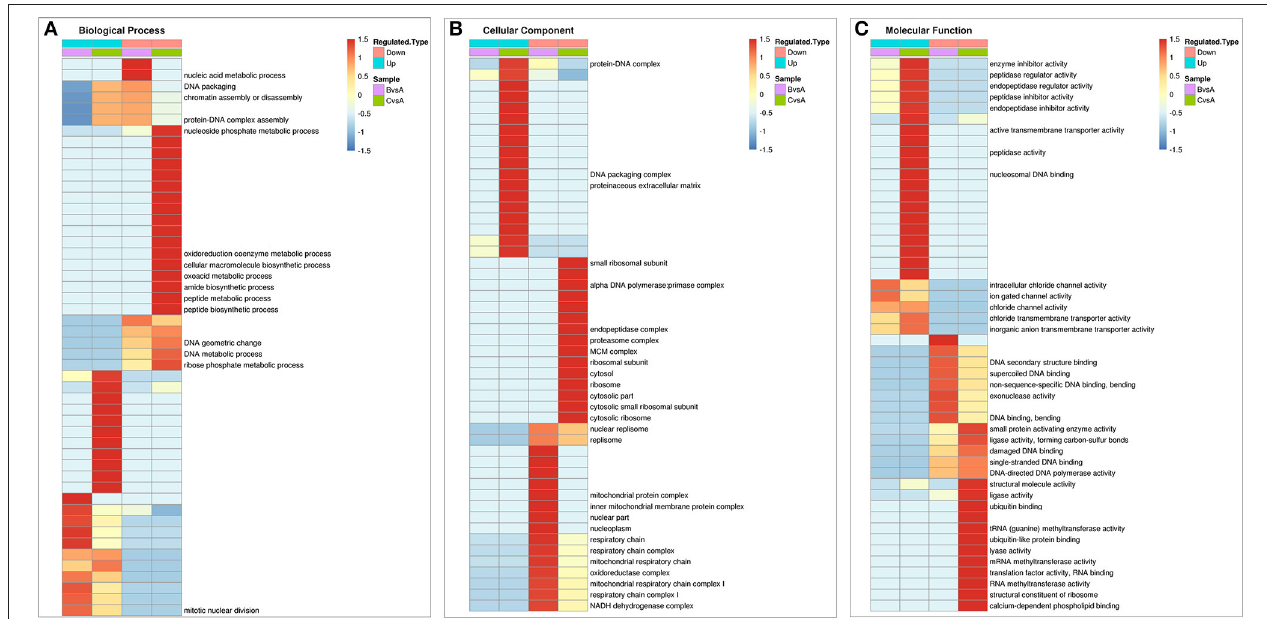
FIGURE 7 | Comprehensive heatmap for cluster analysis of the enrichment patterns of GO functional categories related to cell apoptosis in IPEC-J2 cells. (A) Biological process; (B) Cellular component; (C) Molecular function. (BvsA) indicates the differential proteins enriched in 0.5 mg/mL SBA treatment when compared to control (0.0 mg/mL SBA treatment), (CvsA) indicates the differential proteins enriched in 2.0 mg/mL SBA treatment when compared to control.